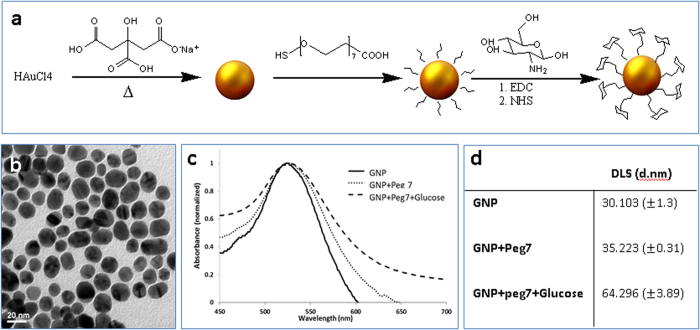
Characterization of GNPs.(a) Schematic diagram of the GNP synthesis process: GNPs were conjugated to the linker PEG7 (95%, Sigma-Aldrich, Israel Ltd) followed by covalent conjugation to glucose (GLU) (D-(+)-Glucosamine hydrochloride, Sigma-Aldrich, Israel Ltd.). (b) TEM image of 20 nm GNPs (scale bar 20 nm). (c) Optical properties of GNPs: UV-vis spectroscopy of bare GNPs, PEG7 coated GNPs and Glucose-PEG7 coated GNPs. (d) Mean hydrodynamic diameter obtained by DLS, at room temperature and at a scattering angle of 90°, at the various stages of GNP coatings. DLS measurements were carried out in triplicate. The significant differences obtained (both by DLS and UV-Vis spectroscopy) following each chemical step, demonstrates the efficiency of the chemical coating.